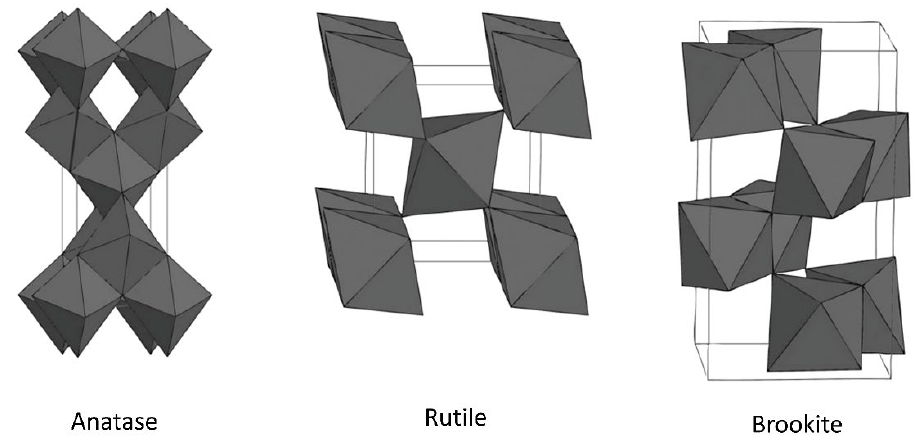
Figure 5. Crystal structures of TiO 2 . Reproduced with permission from [152].